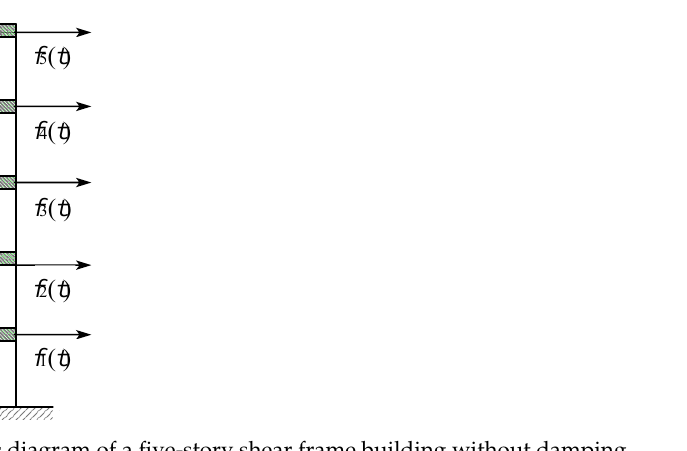
Figure 8. Schematic diagram of a five-story shear frame building without damping. Table 10. Natural frequencies and modal shapes of the building